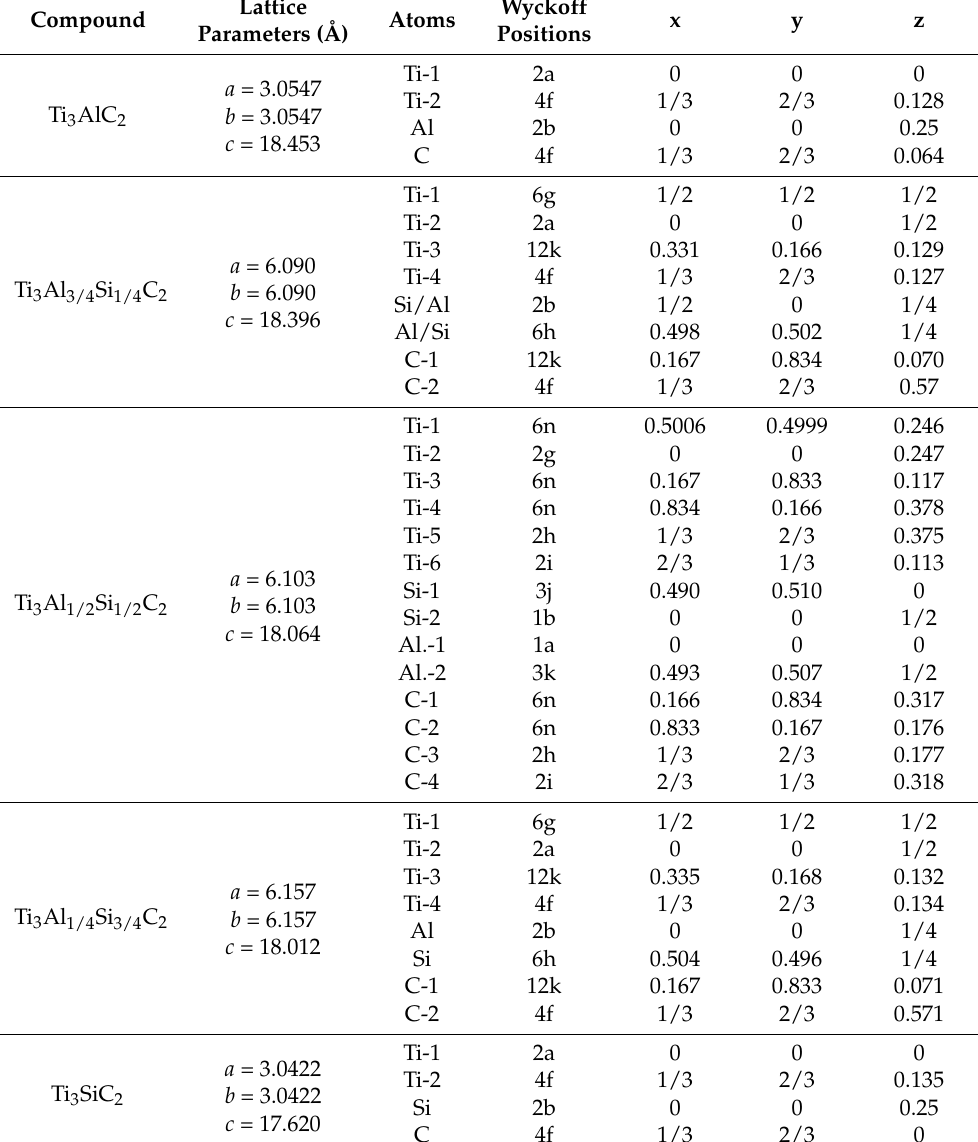
Table 5. Crystallographic information on the Ti 3 AlC 2 , Ti 3 SiC 2 , and Ti 3 Al 1 − x Si x C 2